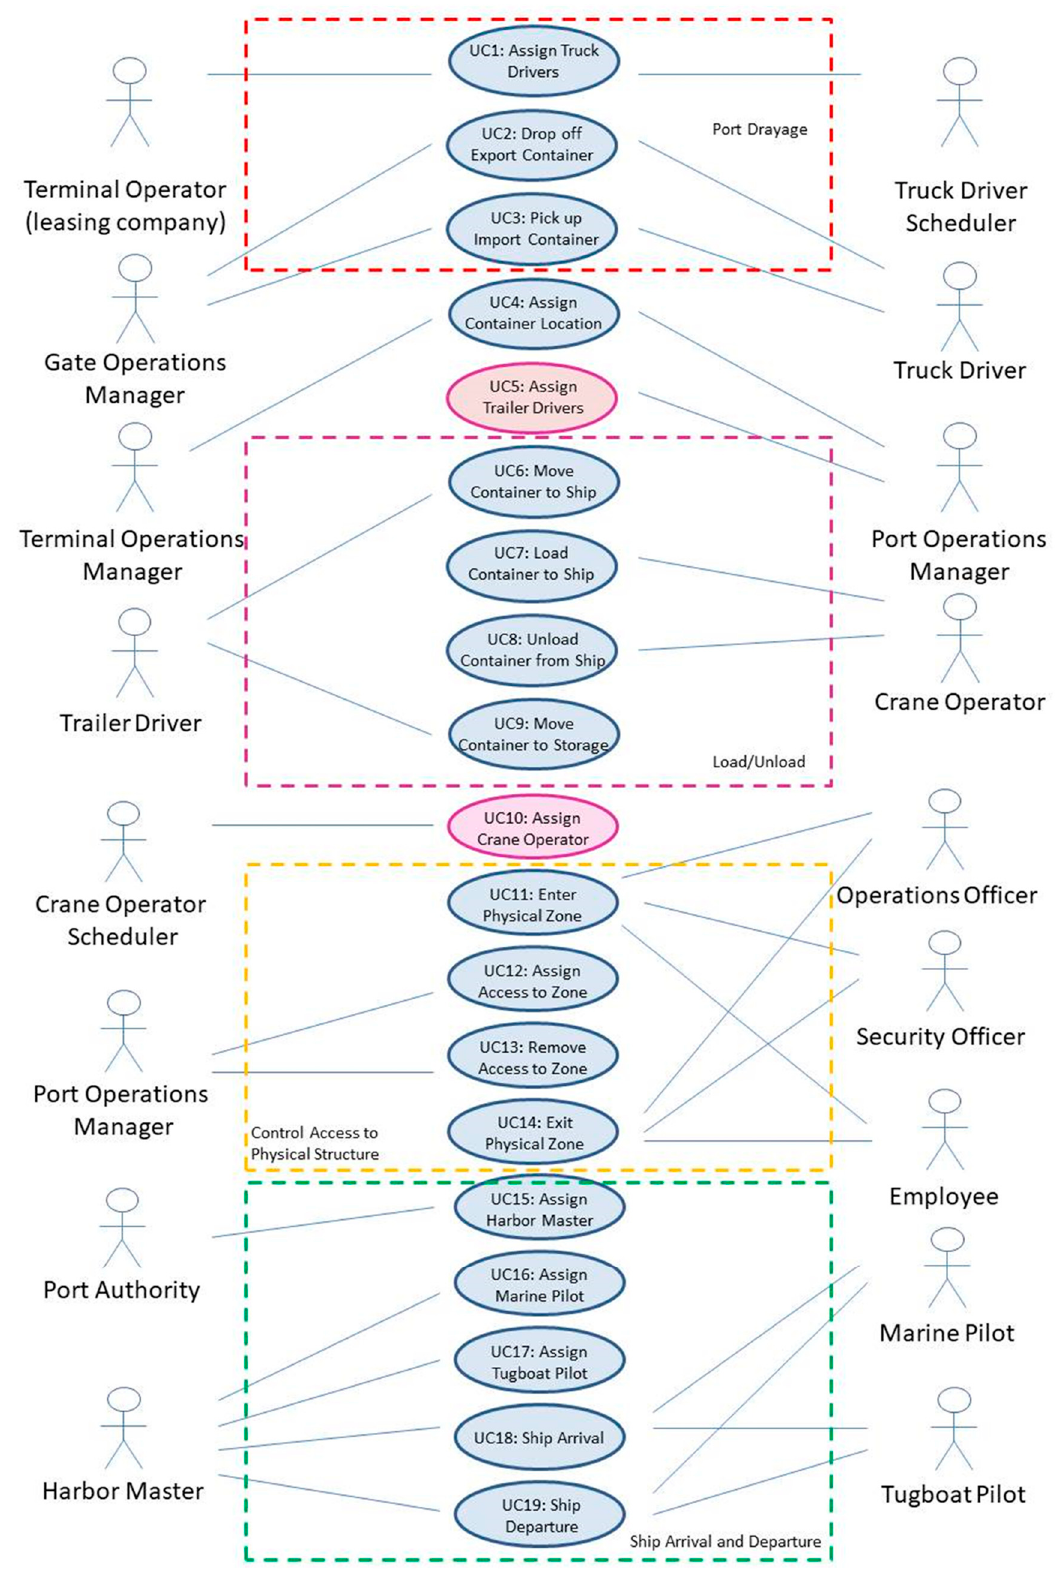
Figure 5. Use cases for a cargo port.